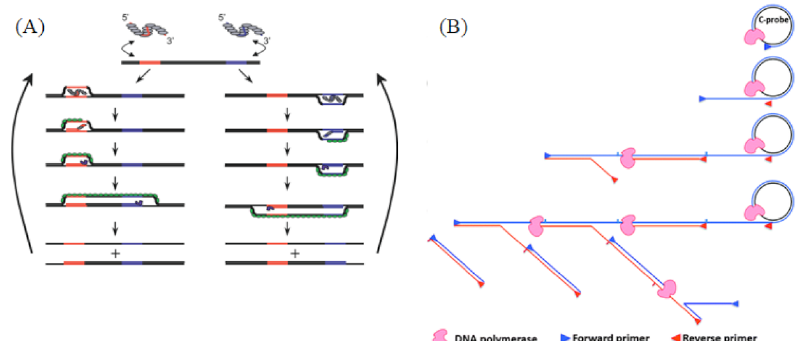
Figure 3. ( A ) RPA reaction mechanism. A recombinase enzyme binds to primers to form complexes that search for homologous sequences in the dsDNA target template and undergo strand displace- ment, in which single-stranded binding proteins (SSBs) bind to replaced DNA strands to prevent chain recombination, and Bsu polymerase amplifies the template. Reprinted with permission from Ref. [48]. Copyright 2006 Piepenburg et al. ( B ) Schematics of HRCA mechanisms. In vitro isothermal linear amplification of the circular DNA template was achieved by the chain displacement synthesis of a primer and circular DNA template under the action of a DNA polymerase with chain displacement activity. Reprinted with permission from Ref. [60]. Copyright 2014, Yan et